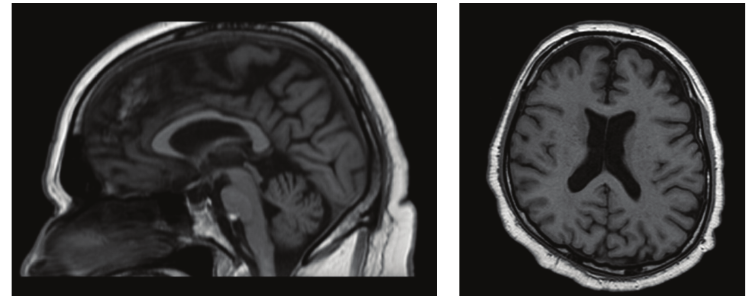
Figure 2: The MRI scan of the brain revealed significant cerebral